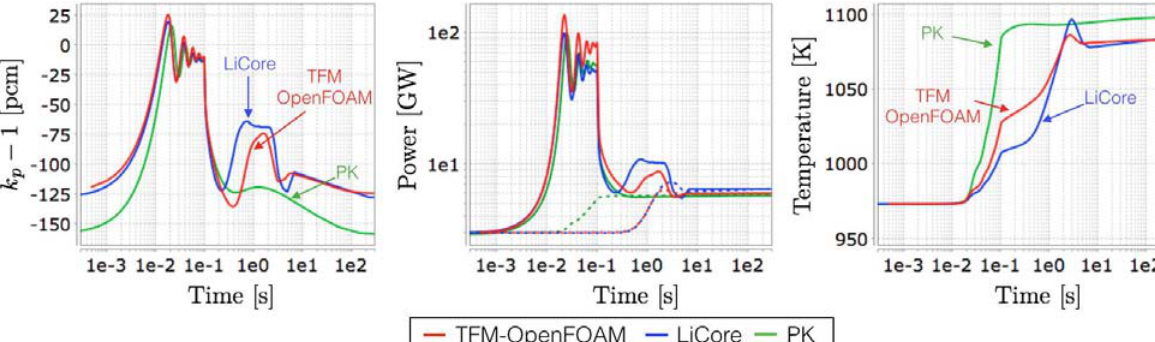
Figure 4. Comparison of LiCore, TFM-OpenFOAM and PK model on an insertion of 1000 pcm in